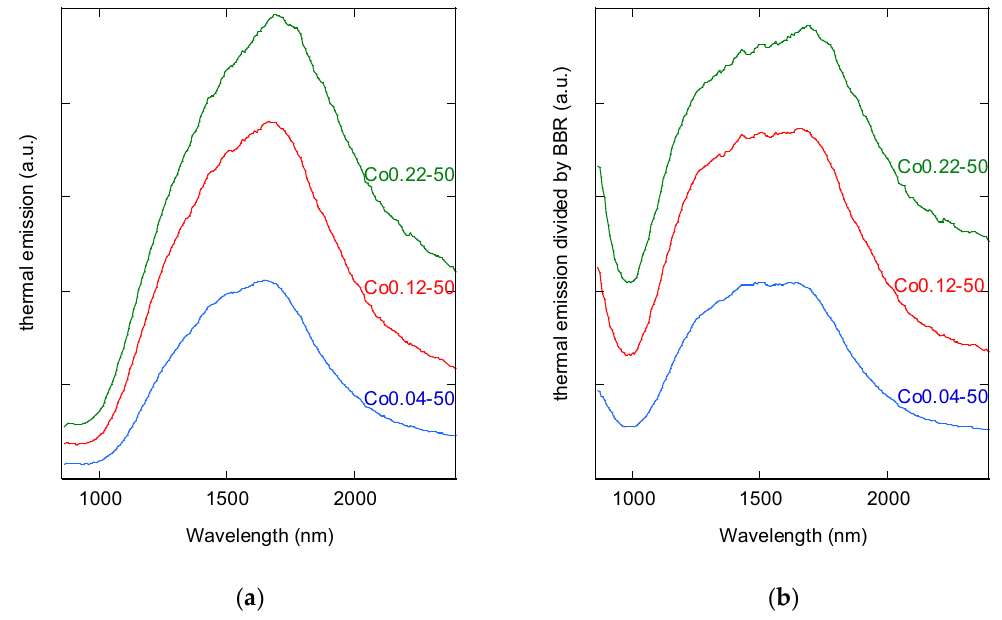
Figure 3. ( a ) Thermal emission of Co0.04-50, Co0.12-50 and Co0.22-50 eutectic rods measured at 1300 °C; ( b ) spectra obtained by dividing the thermal emission spectra by the Planck profile at 1300 °C.